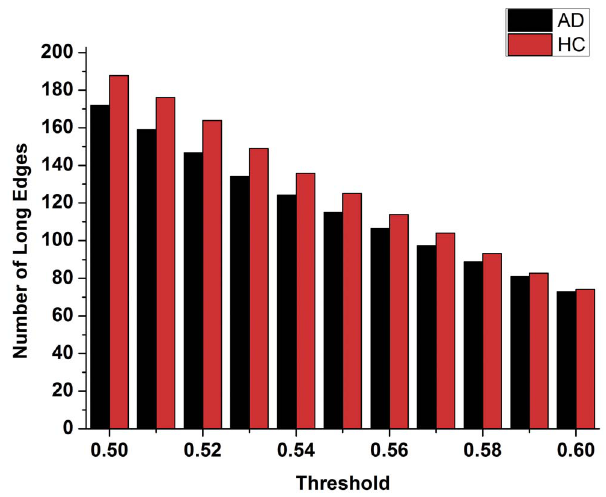
Figure 2. The number of edges of the functional brain network of healthy controls, AD patients and evolution under different thresholds. Blue triangle represents the healthy control group, black rectangle represents the group of patients with AD, the red dot represents the evolution network group.